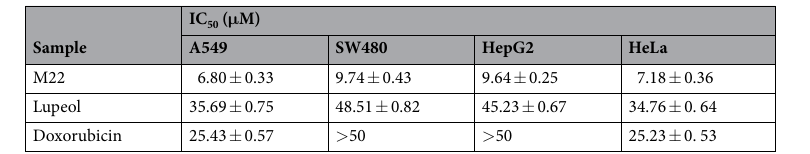
Table 1. IC 50 values of lupeol derivatives M22 against four human cancer cell lines for 48